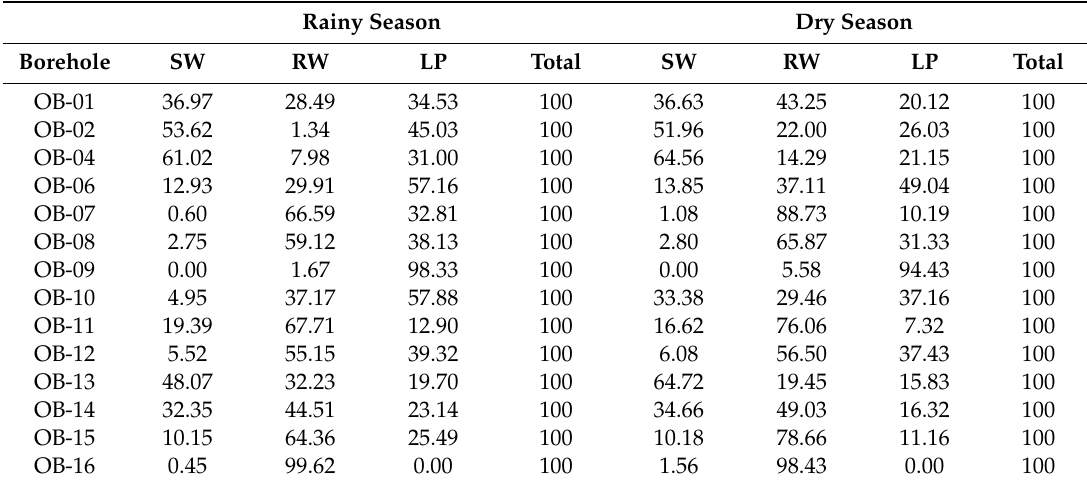
Table 2. Contribution (%) of seawater (SW), Red River’s water (RW) and local precipitation (LP) to groundwater in Holocene aquifer in study region during rainy and dry seasons. Rainy Season